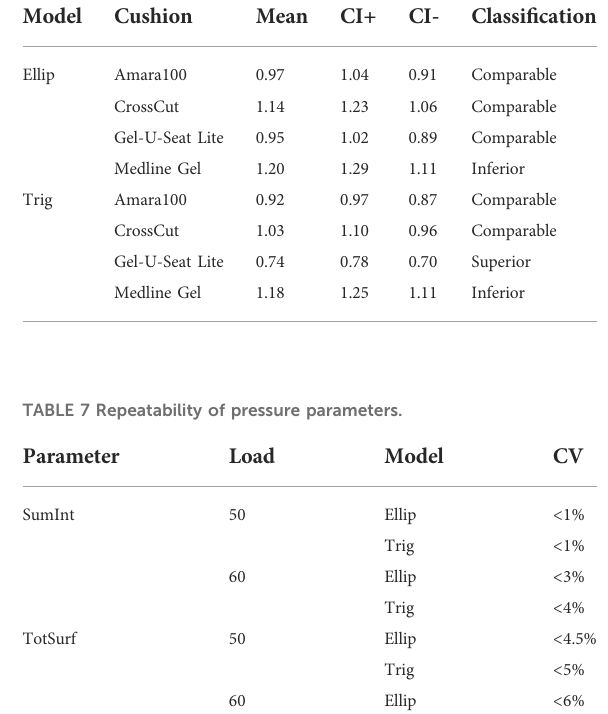
parameters were assessed using the coef fi cient of variation (Table 7). The variation across repeated trials re fl ect the differences in reliability of the internal and surface sensors within their respective contexts of use. Overall, the results indicate a high repeatability across the trials.